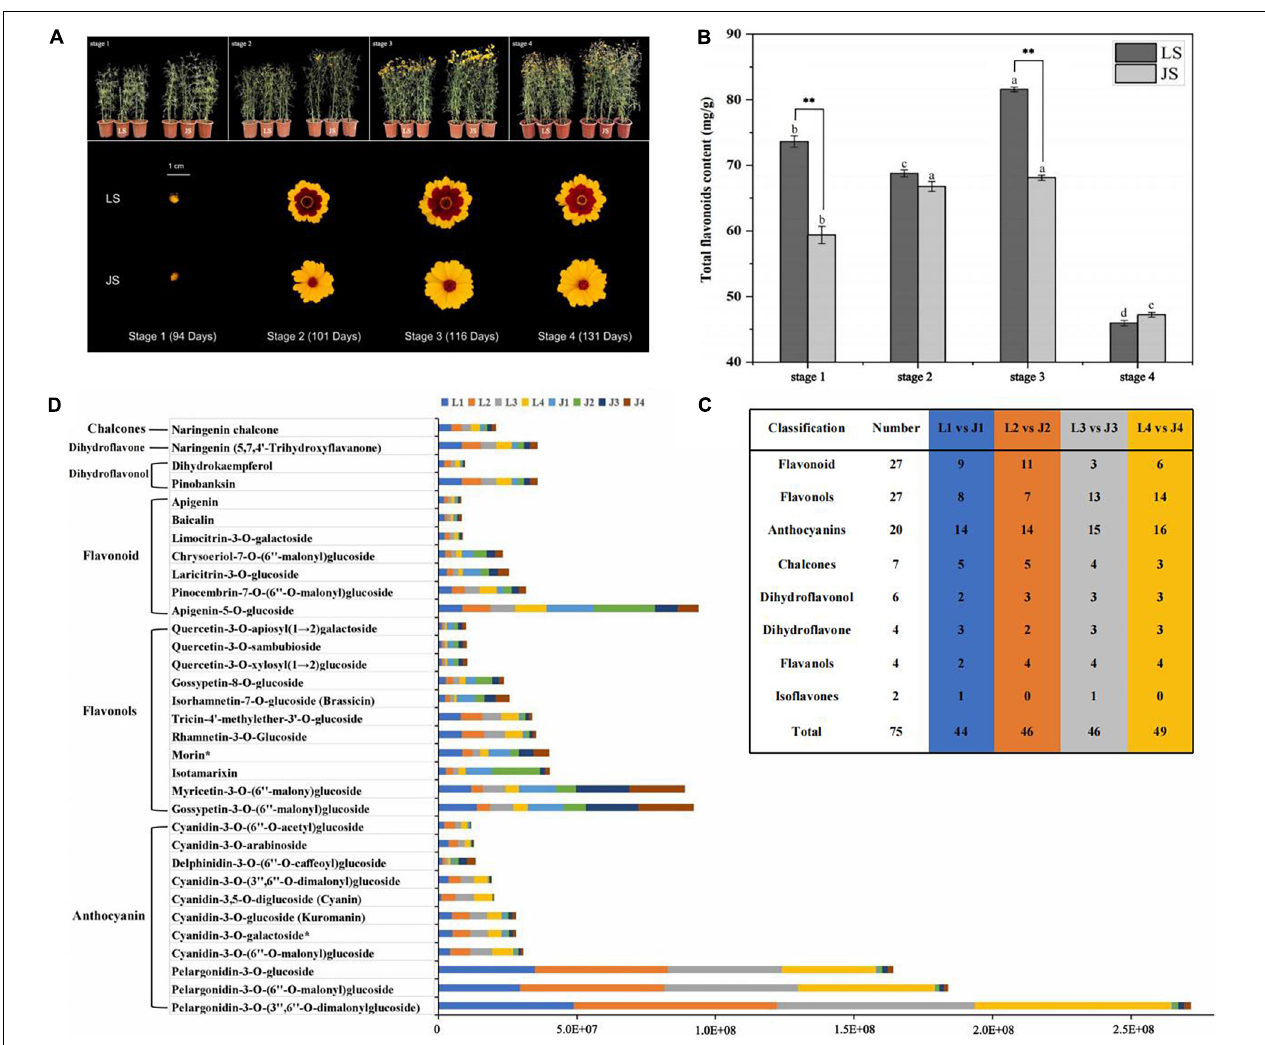
FIGURE 1 | Sampling and analysis of flavonoids metabolites. (A) Morphology of four stages of two colors of C. tinctoria. (B) Total flavonoid content of LS and JS at four stages. (C) Statistics on the types of DAFs among different comparison groups. (D) The relative content of 33 differential accumulation of flavonoids (DAFs) accumulated at different stages in LS and